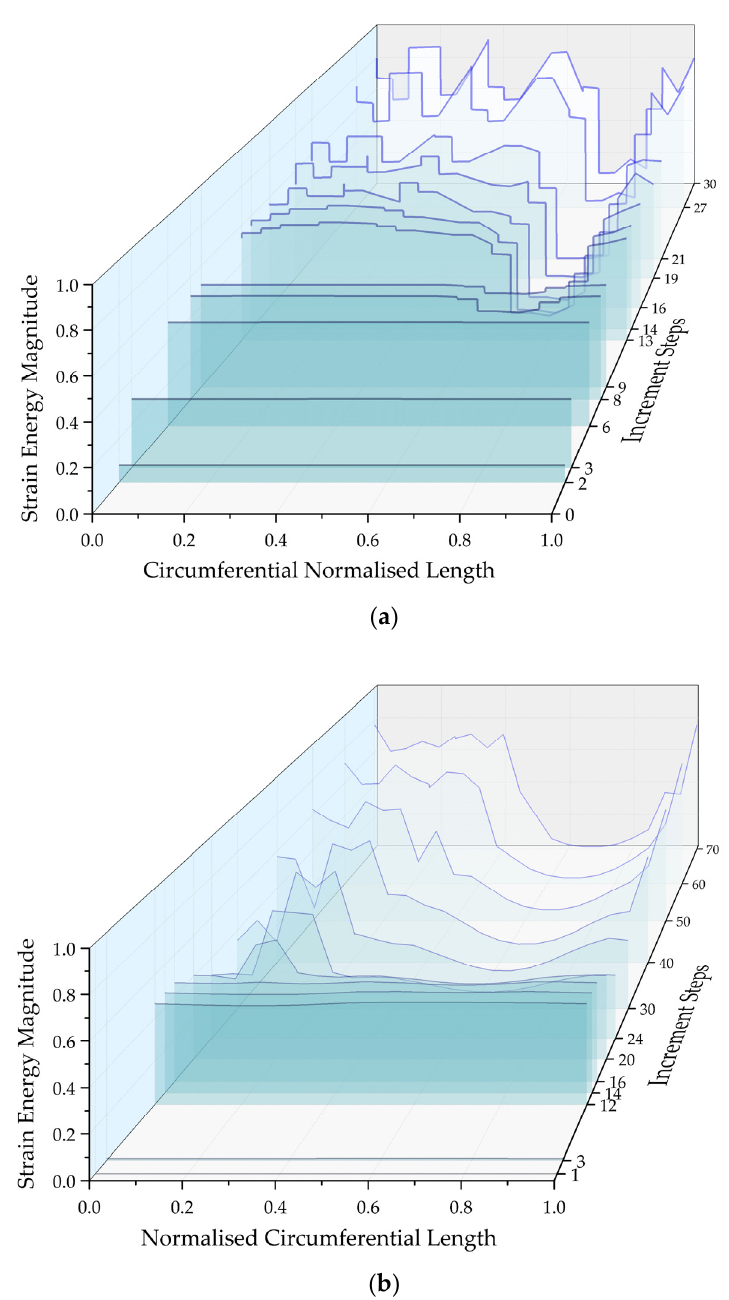
Figure 24. Shell strain energy magnitude along the normalised longitudinal length under combined loads, at typical increment steps: ( a ) 9 m at 24 mm shell and ( b ) 24 m at 24 mm shell.